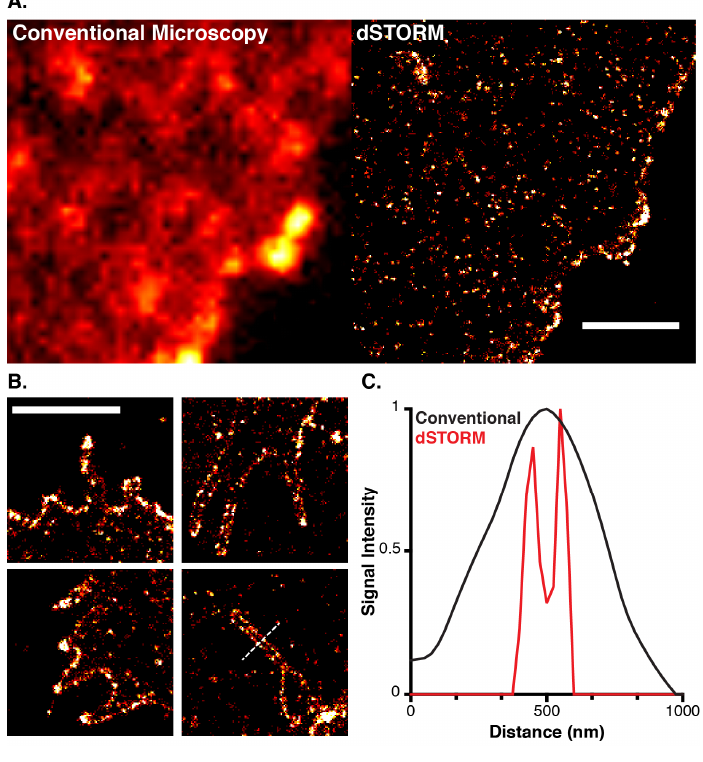
Figure 4. A Virus’ Eye View of CD81. ( A ) Fixed human hepatoma Huh-7.5 cells labeled with Alexa Fluor 647 conjugated anti-CD81 imaged by conventional TIRF microscopy and dSTORM, as described in Metcalf et al . [21]; ( B ) Enrichment of CD81 on membrane tubules, most likely microvilli; ( C ) A line profile taken through the membrane structure indicated in lower right ( B ), the lumen of the tubule is clearly discernable in the dSTORM plot (red), whereas the corresponding conventional microscopy plot (black) is relatively featureless. Scale bars, 2